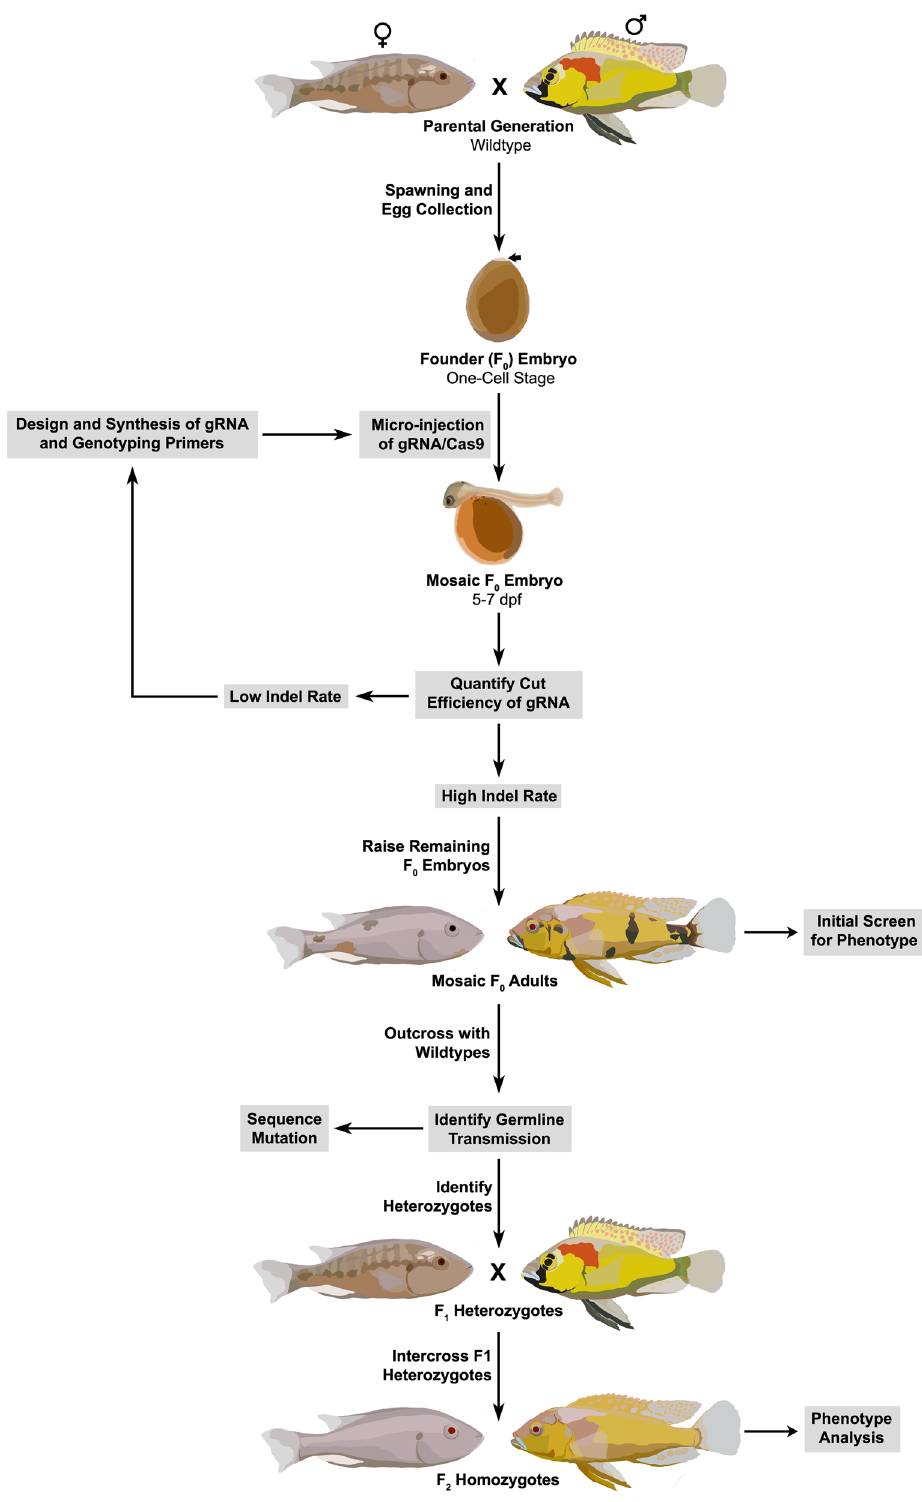
Figure 1. Overview of CRISPR/Cas9 mutagenesis workflow . Single-cell wildtype embryos are collected for microinjection with gRNA and Cas9 protein. At 5–7 days post-fertilization (dpf), indel mutation efficiency is assessed via PCR fragment size analysis. If indel rates are low, troubleshooting is initiated. Targeting the Tyrosinase ( Tyr1 ) locus facilitates this process due to its visible phenotype. New gRNAs may improve mutagenesis rates. If indel rates are high, adult injected (F 0 ) fish are screened for initial phenotypes and outcrossed to wildtype animals. Resulting F 1 animals are screened for heterozygotes and sequenced to determine the mutation. Adult F 1 may be intercrossed, and F 2 offspring are used to determine phenotypes in homozygous mutants. Routine outcrosses are recommended to mitigate the impact of off-target